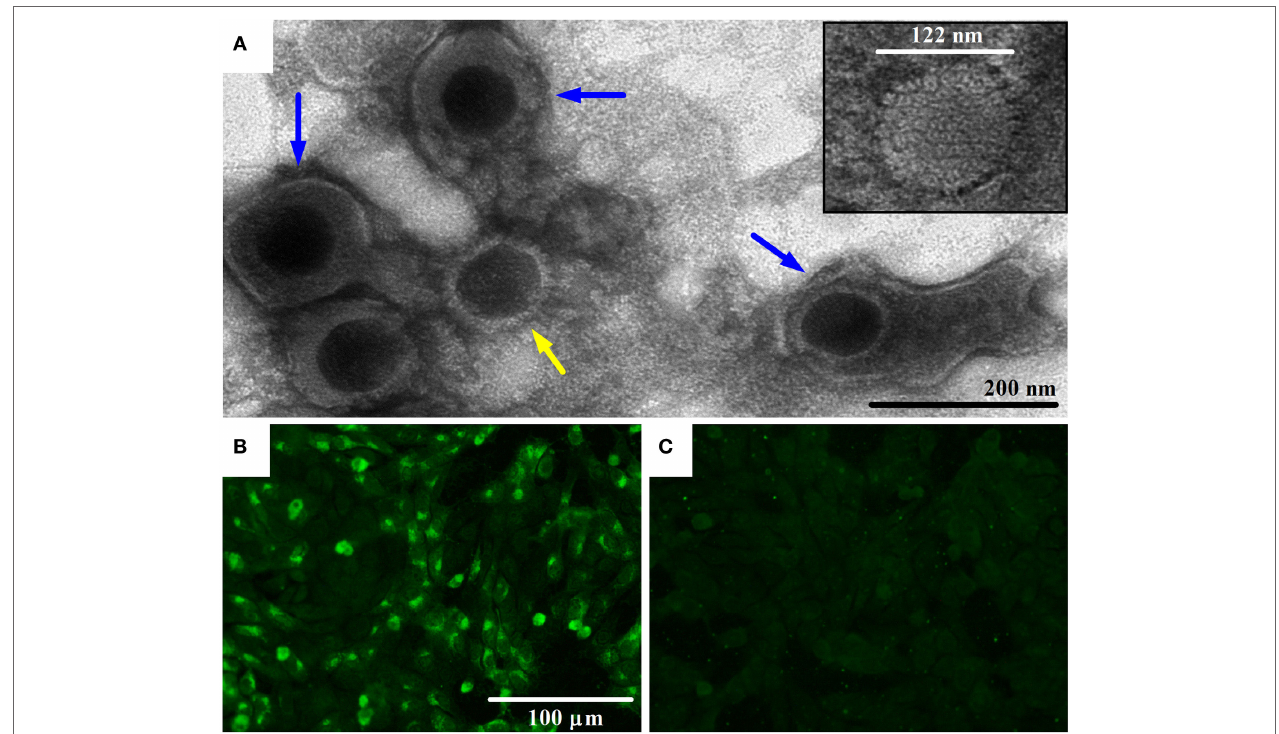
FigUre 1 | Transmission electron microscopy (TEM) image of bovine gammaherpesvirus 4 (BoHV-4)-FMV isolate and detection of its antigens by indirect immunofluorescence assay (IFA). (a) TEM image of BoHV-4-FMV virus isolate grown on MDBK cells, showing herpesvirus-like virions. Negative-stain TEM allows the visualization of enveloped (blue arrows) and non-enveloped (yellow arrow) herpesvirus particles. A more detailed icosahedral capsid structure of the virus with an overall size of 122 nm in diameter, with its capsomere subunits, is illustrated in the inset. (B) Visualization of BoHV-4-FMV MDBK-infected cells by a specific IFA. (c) Mock MDBK-infected